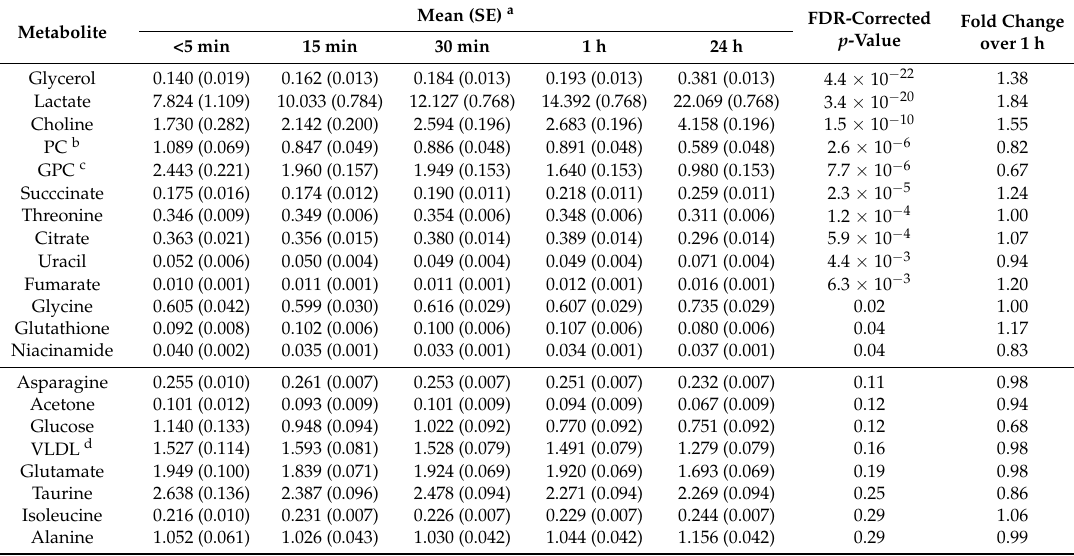
Niacinamide 0.040 (0.002) 0.035 (0.001) 0.033 (0.001)